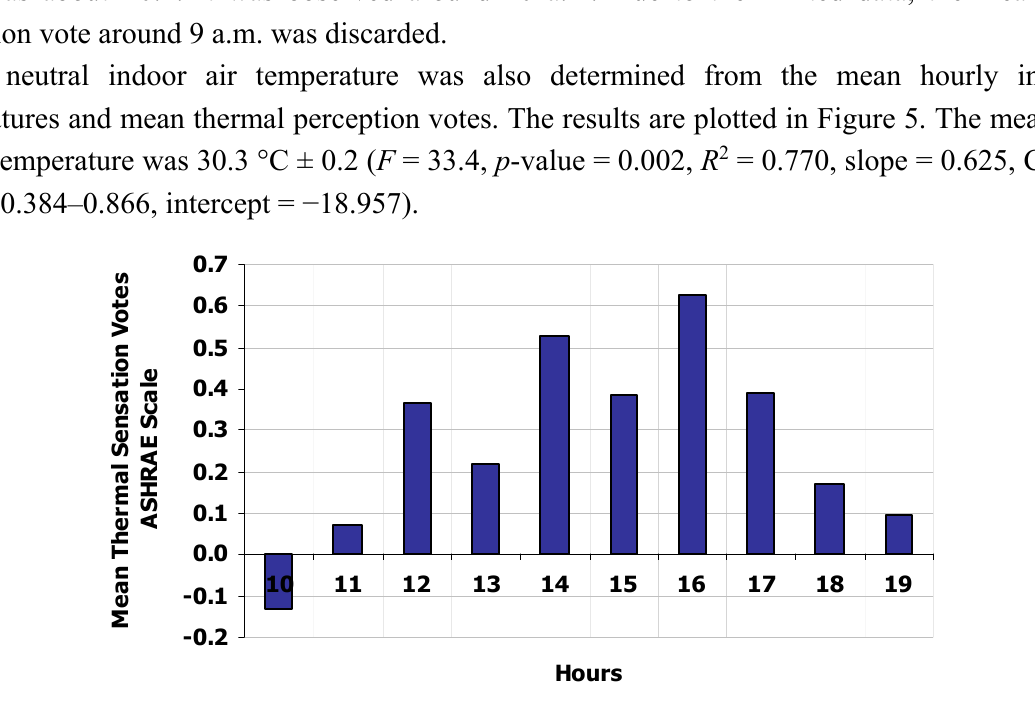
Figure 4. Hourly mean thermal sensation vote on the ASHRAE